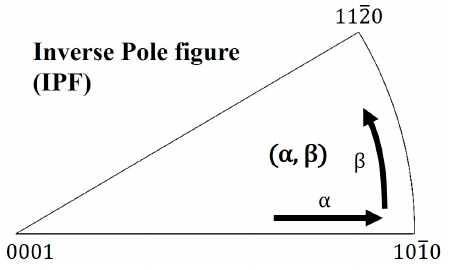
Figure 2. Inverse pole figure triangle method of expressing the textures. The main texture component is mainly observed as a contour plot, and the highest point is represented in the ( α , β ) coordinate system.